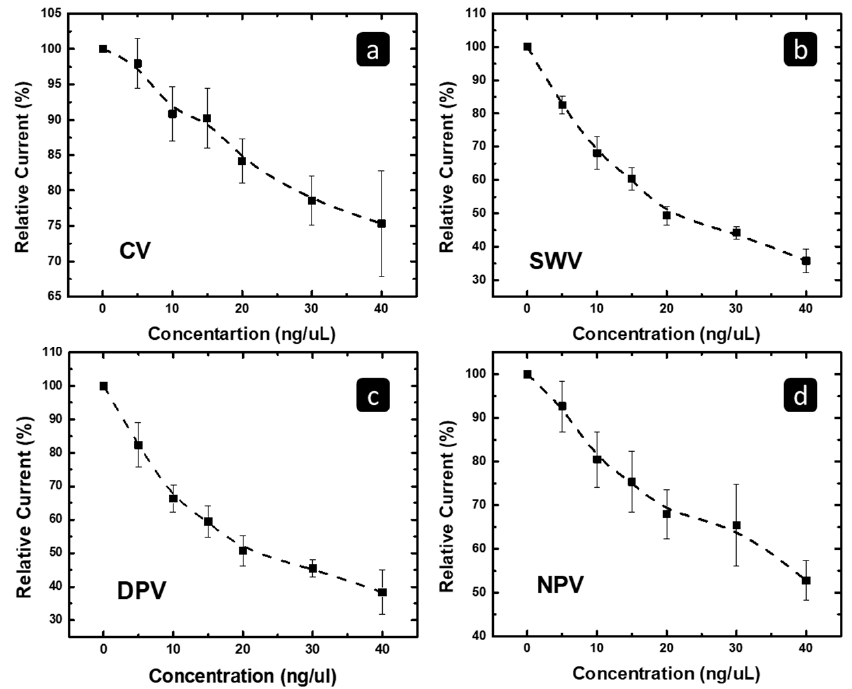
Figure 9. The correlation between relative suppression of the peak current of the ( a ) CV, ( b ) SWV, ( c ) DPV, and ( d ) NPV techniques versus the concentration of the MCF7/ADR exosomal RNA. On the other hand, to highlight the concentration range in which the response has linearity with the concentration of the MCF7/ADR RNA, Figure 10 shows the correlation between (a) the CV, (b) SWV, (c) DPV, (d) NPV peak current/limiting current and the concentration of the MCF7/ADR RNA, at the concentration range of 0–20 ng/uL. The R 2 and a limit of detection (LOD) based on the linear fit of the data are summarized in Table 3. The SWV gave the best R 2 of 0.97; the lowest limit of detection was “4.8 ng/ µ L”, and the most significant concentration was 20 ng/ µ L for the MCF7/ADR exosomal RNA Detection. All the MCF7/ADR results, regardless of the technique, were nonsignificant for the concentration range from 20 to 40 ng/ µ L due to the high value of the error bar at this range of concentration. The error bars showed a high degree of overlap, which reflects the uncertainty in the correlation between the concentration and